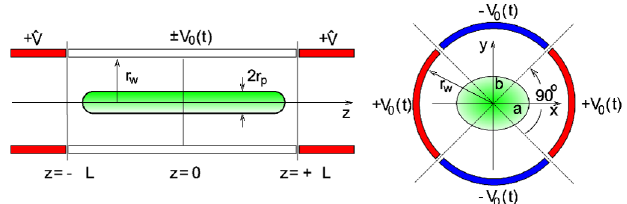
FIG. 1. (Color) The PTSX device consists of three cylindrical (cid:3) 0 : 1 m , each divided into four 90 (cid:4) electrodes with radius r w (cid:6) t (cid:7) confines the charge bunch sectors. An oscillating voltage (cid:5) V 0 . Static voltages (cid:8) ^ V on the in the transverse plane to a radius r p end electrodes confine the ions axially within a length 2 L (cid:3) 2 m